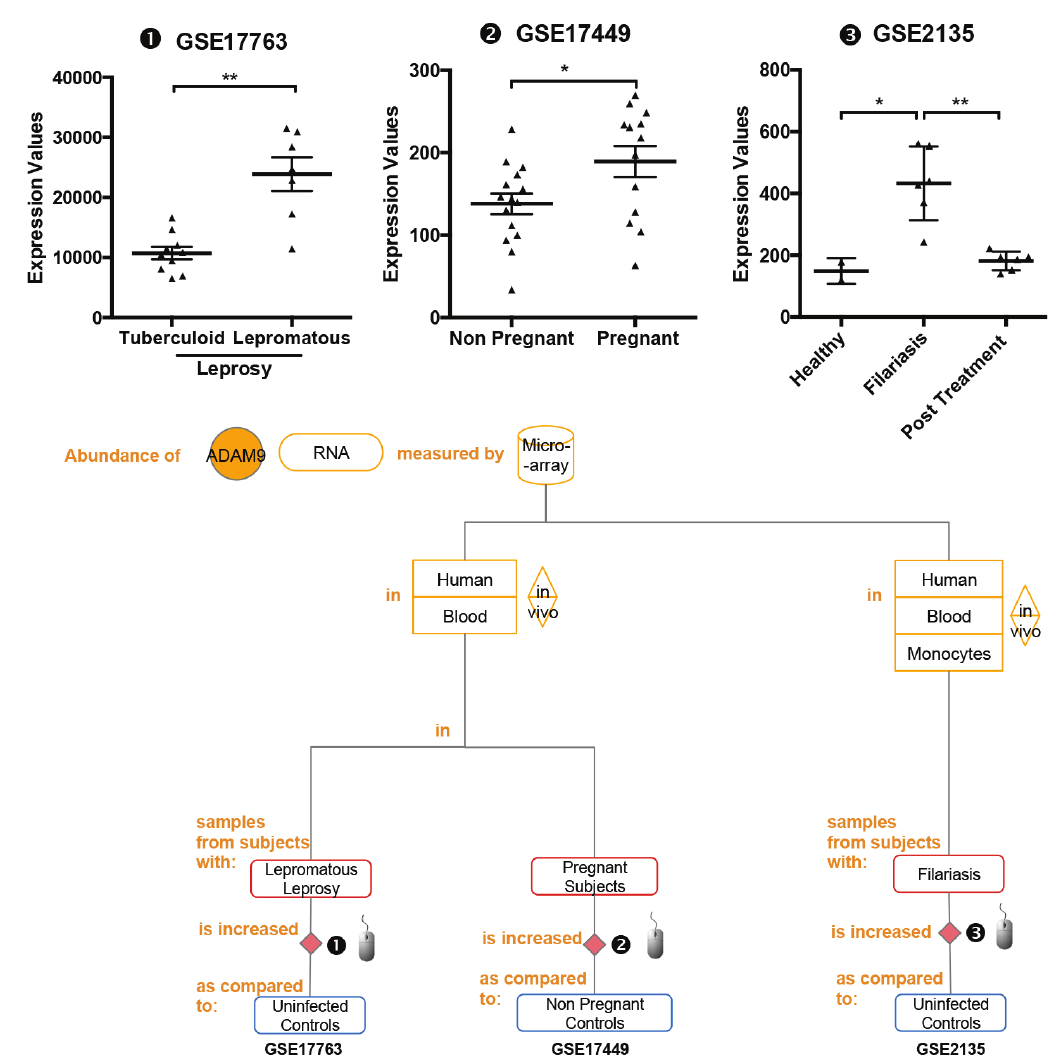
Figure 4. The abundance of ADAM9 increases during tissue remodeling. mRNA expression levels for ADAM9 was measured by microarrays in skin biopsies were obtained from patients with leprosy classified as tuberculoid leprosy or lepromatous leprosy (GSE17763), Peripheral Blood Mononuclear Cells obtained from 12 women (7 MS patients and 5 healthy controls) followed during their pregnancy (GSE17449) and monocyte from flilariasis before and after treatment (GSE2135). The graphical legend represents visually the information associated with the public datasets used for the meta-interpretation of ADAM9 transcriptional profiles. The flow chart indicates how data were generated. Diamonds indicate availability of supporting data and in the interactive version are hyperlinked to context-rich interactive plots. Links to these plots are also provided below: ❶ GSE17763 Skin biopsies were obtained from patients with leprosy classified as tuberculoid leprosy (controlled disease, few skin lesions) or lepromatous leprosy (uncontrolled diseases, widespread lesions) 31 . All tuberculoid and lepromatous specimens were taken at the time